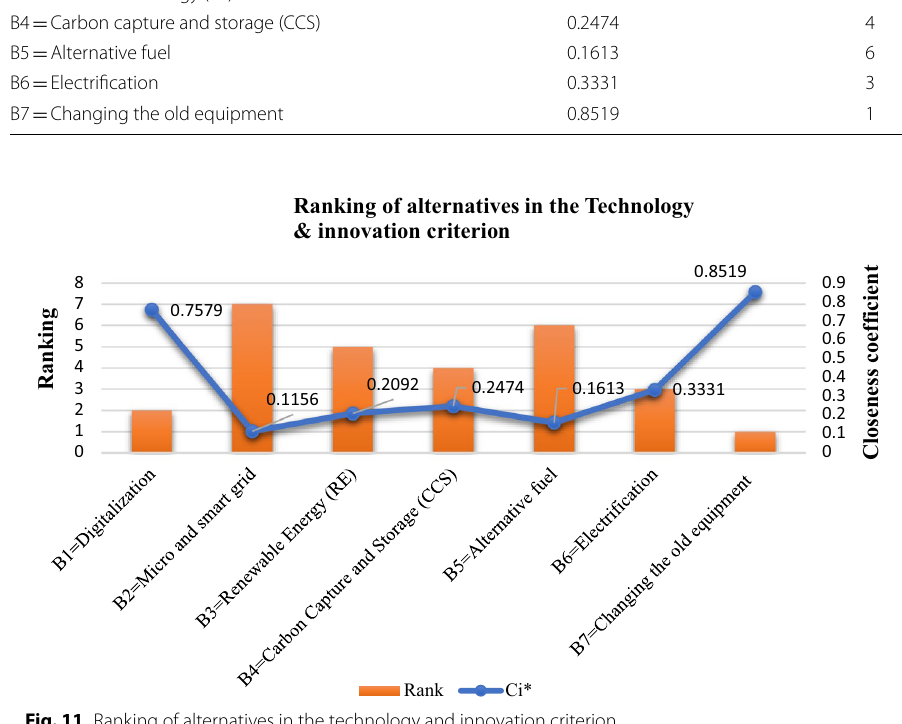
Fig. 11 Ranking of alternatives in the technology and innovation